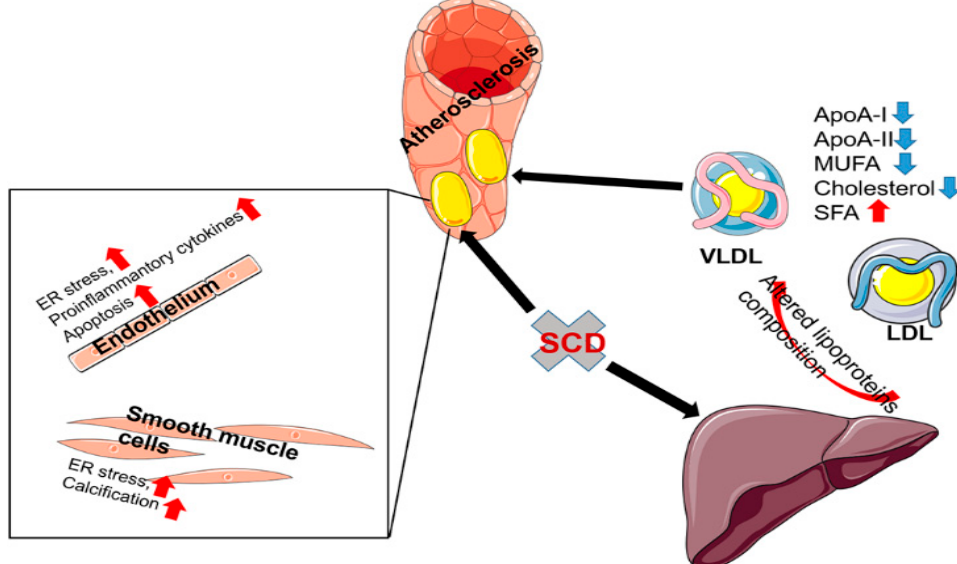
Figure 2. SCD1 deficiency promotes the development of atherosclerosis. SCD1 ablation modifies the composition of hepatic very-low-density lipoprotein (VLDL) and low-density lipoprotein (LDL), decreases the content of ApoA-I, ApoA-II, MUFA, and cholesterol, and increases the content of SFA, which contributes to atherosclerosis development. SCD1 ablation stimulates smooth muscle cell calcification by inducing ER stress. The inhibition of SCD1 activity in endothelial cells stimulates the secretion of proinflammatory cytokines and induces apoptosis. Altogether, this leads to the development of atherosclerosis. The red arrow indicates the activation of the process. The blue arrow indicates the decrease of the process/decline of the content of a given factor.